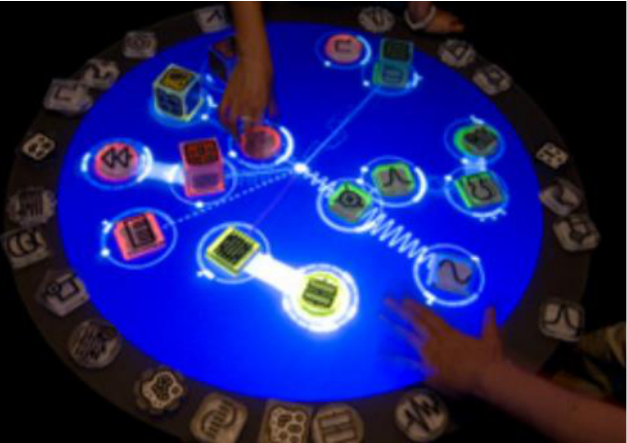
Figure 31. Spyractable consists of: Reactable and tokens with tags in action [55]. Gohlke et al. from Bauhaus University Weimar proposed a TUI for music production by Lego Bricks. Interface widgets (Lego tokens) were created from Lego bricks, tiles, and plates. They are constructed as rotary controls, linear sliders, x/y pads, switches, and grid areas. The technical concept consists of Lego bricks, a backlight translucent Lego baseplate, camera, OpenCV library. Lego tokens are put on the Lego baseplate and scanned by the camera (see Figure 32). An OpenCV library is used for image processing in real-time. The position, color, orientation, and shape of the bricks are tracked using the camera. The system allows the creation of rhythmic drum patterns by arranging colored Lego tokens on the baseplate